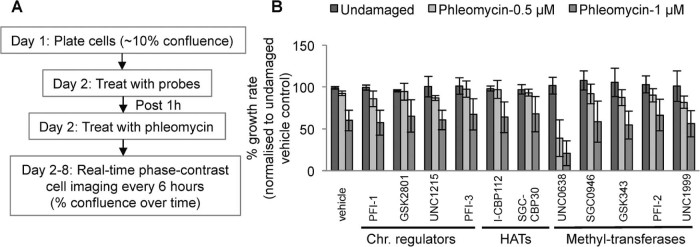
Screening chemical probe inhibitors identifies UNC0638 as potentiating with phleomycin to impede cell proliferation. (A) Schematic elaborating the screening strategy. (B) U2OS cells were seeded in 96 well plates at ~10% confluence and treated with vehicle (1% DMSO), small-molecule inhibitors targeting chromatin modulators (Chr. Regulators; PFI-1, GSK2801, UNC1215, PFI-3), histone acetyl-transferases (HATs; I-CBP112, SGC-CBP30) and histone methyl-transferases (UNC0638, SGC0946, GSK343, PFI-2, UNC1999). Details of inhibitors used are provided in Supplementary Table S1. One-hour post treatment, cells were damaged with low doses of phleomycin (0.5 µM or 1 µM) and were allowed to proliferate for 6 days. The area occupied by cells (% confluence) over time is a surrogate marker for proliferation. Data presented here provide percentage growth rates of cells over a period of 6 days. Error bars correspond to SDs of three independent experiments. Small-molecule Inhibitor UNC0638 inhibiting G9a methyl-transferase hypersensitised U2OS cells to DSB-inducing agent phleomycin at both phleomycin concentrations tested.